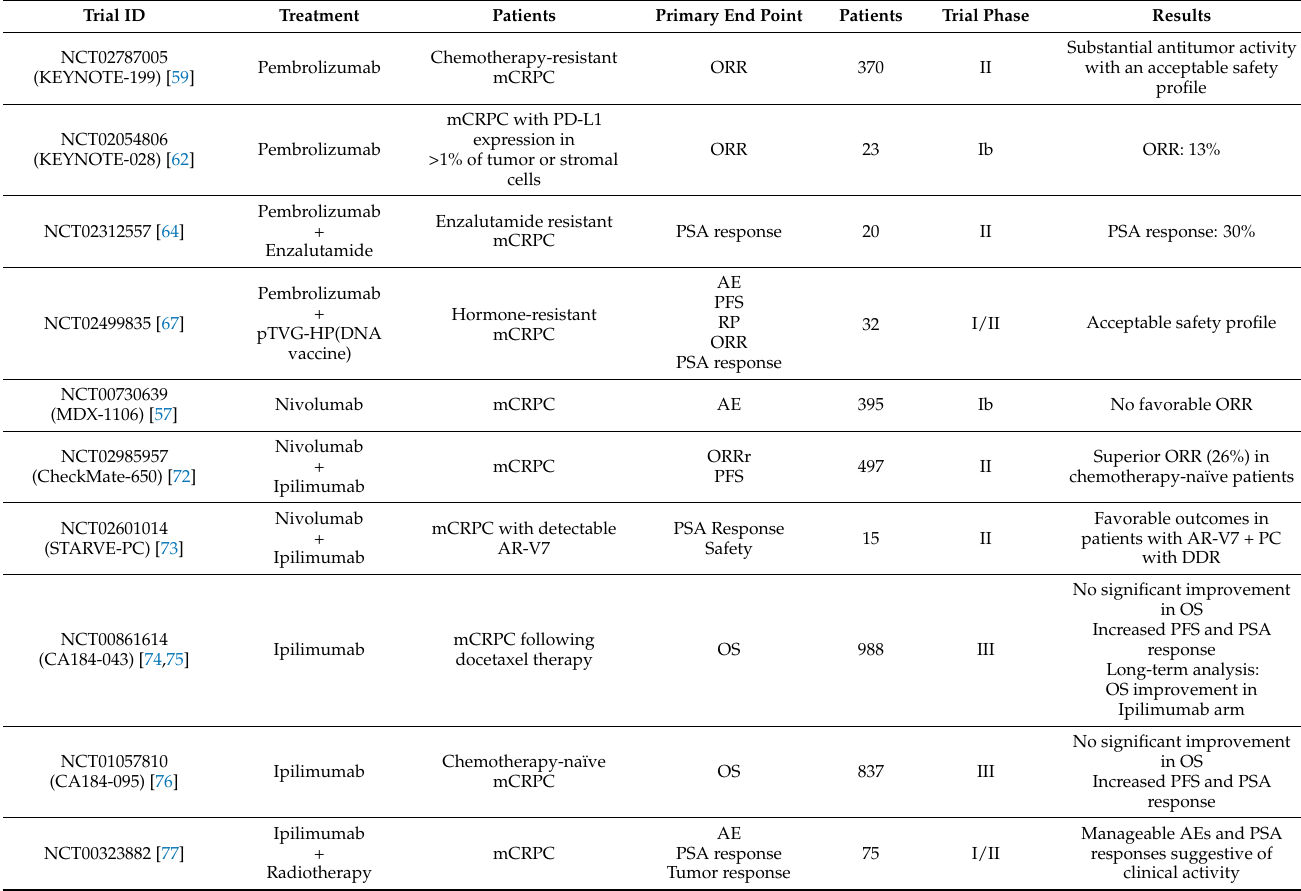
Table 1. Summary of completed clinical trials evaluating the efficacy of ICIs in monotherapy and in combination with other treatments in mCRPC. AE: adverse events; MTD: maximum tolerated dose; ORR: overall response rate; OS: overall survival; PFS: progression-free survival; rPFS : radiographic progression-free survival; RP: radiographic progression. Trial